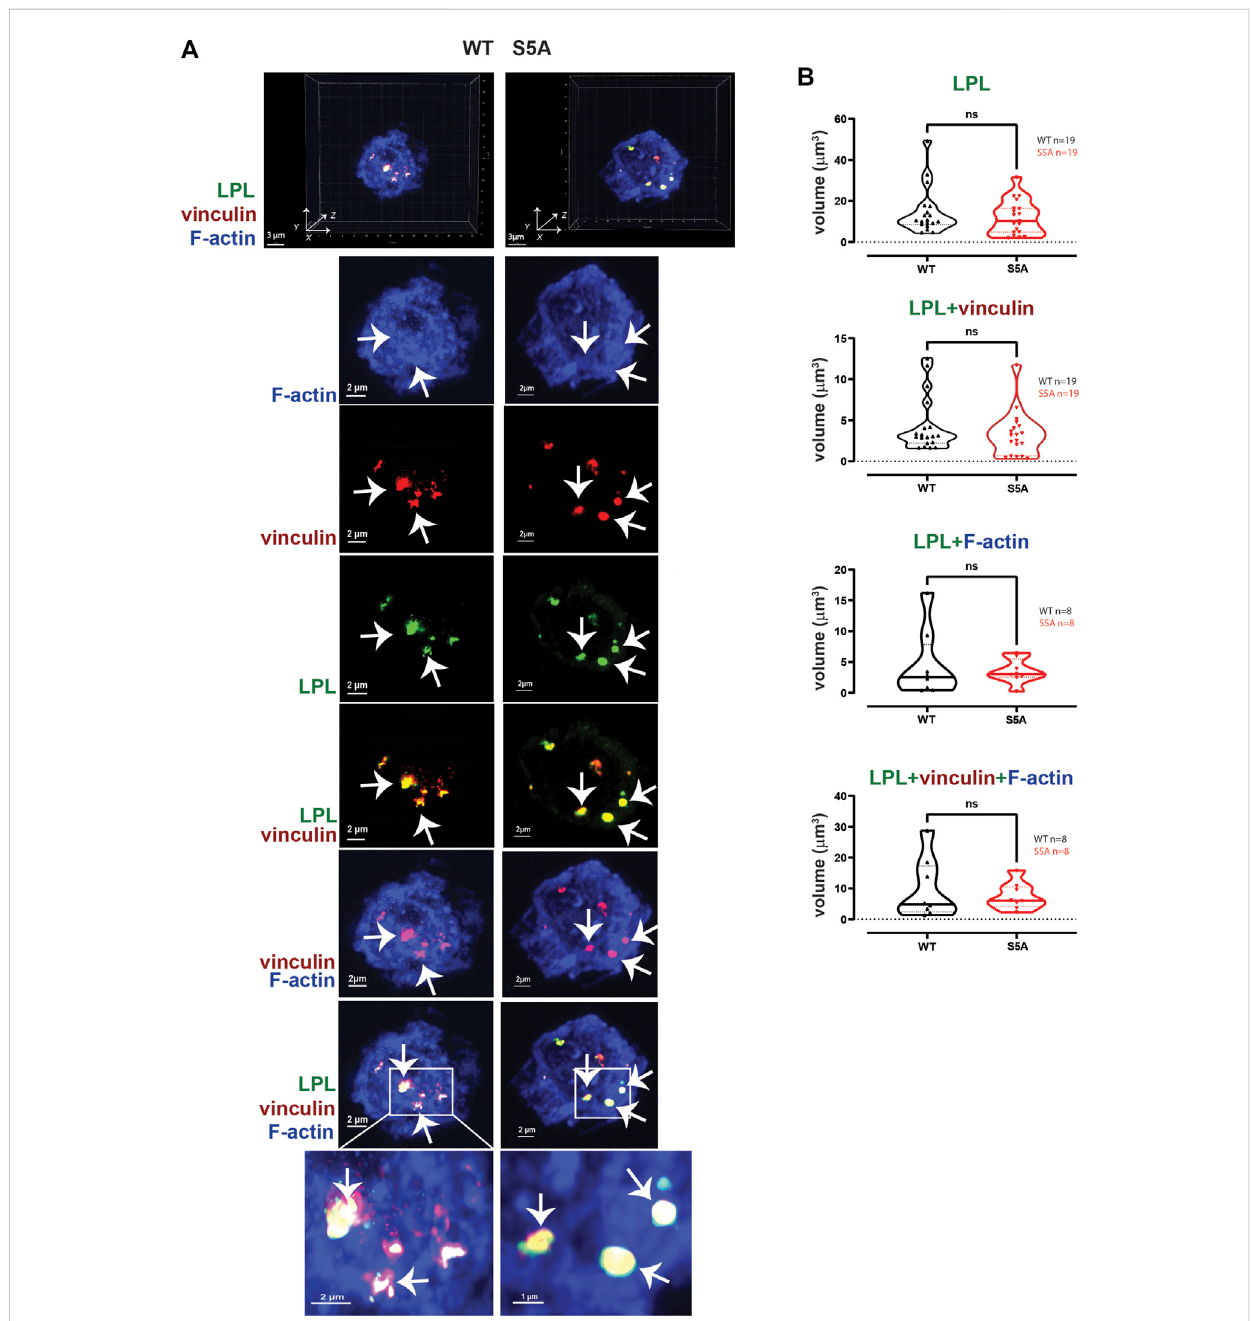
FIGURE 4 WT-LPL or S5A-LPL co-localize equivalently with vinculin and/or F-actin in AMs after serum stimulation. (A) Co-localization of LPL (green), vinculin (red) and F-actin (blue) in serum stimulated AMs from matched WT and S5A mice. Images in top panels show 3D reconstruction of Z-stack confocal micrographs.Otherpanelsare2DXYprojectionsshowingindividualproteinsandoverlaysofLPL+vinculin(yellow),vinculin+F-actin(purple),andofLPL + vinculin + F-actin (white). Representative podosomes are indicated by white arrows and magni fi ed in insets. Grids show 2 μ m increments and are optimal for size assessment; scale bars in subsequent panels are derived from grids. (B) Total volume of aggregates of LPL, LPL + vinculin, LPL + F-actin, and of LPL + vinculin + F-actin. Each symbol represents the volumes calculated from one AM; n = number of cells analyzed. Images acquired from two independent experiments. p -values determined by Mann-Whitney; ns = non-signi fi